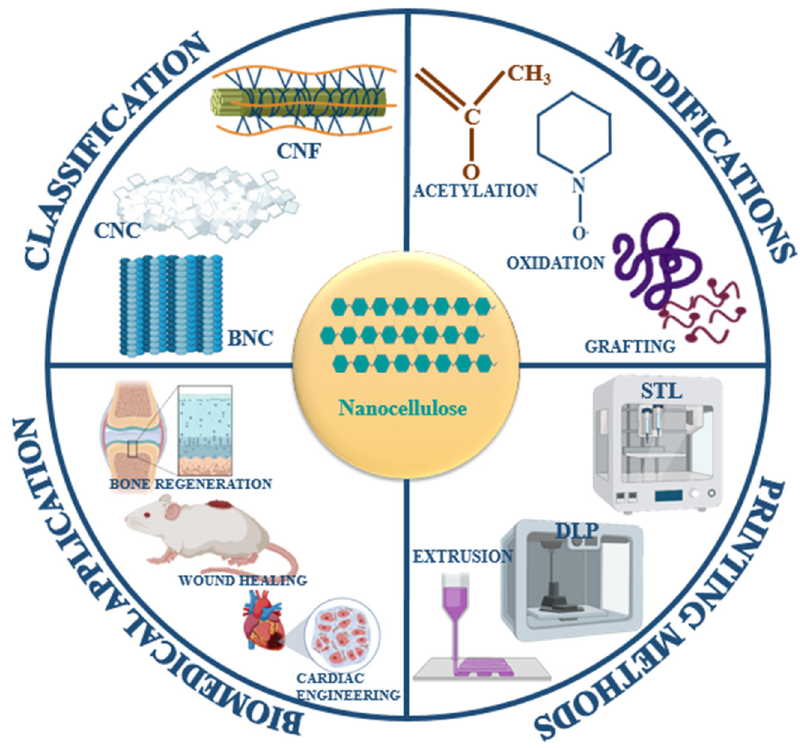
Figure 1. Schematic representation of the classification, modifications, printing methods, and biomedical applications of nanocellulose and its derivatives.